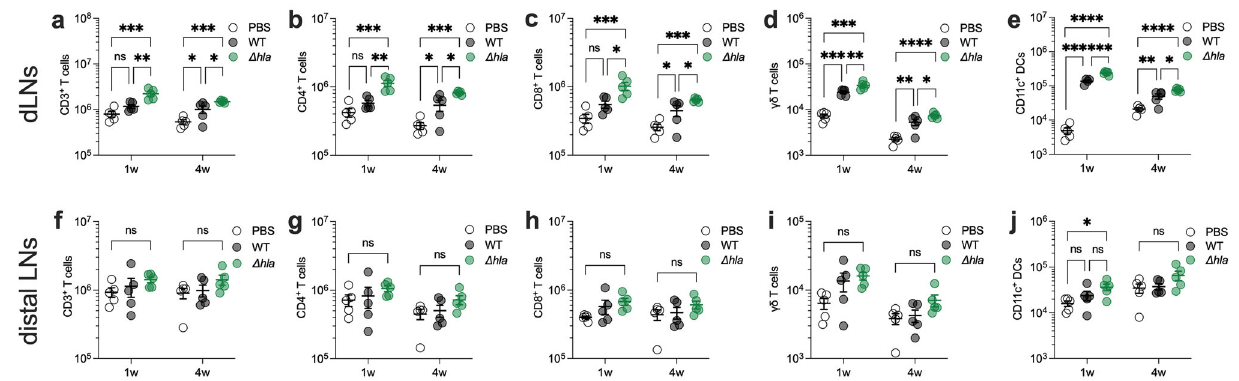
Fig. 5 Hla expression during SSTI durably impairs the expansion of T cells and dendritic cells in draining lymph nodes. Following SSTI with wild-type (WT) S. aureus or an isogenic hla deletion mutant ( Δ hla ), local draining lymph nodes (dLN) or distal LN were harvested 1 and 4 weeks after infection, and fl ow cytometry performed to quantify CD3 + , CD4 + , CD8 + , or γδ T cells and CD11c + dendritic cells (DC). a – e There were higher numbers of all cell populations tested in local dLNs following infection with Δ hla , compared with WT. These differences persisted for 4 weeks following the infection. f – j In contrast, there were no signi fi cant differences in the numbers of T cells and DCs in distal LNs 1 or 4 weeks following infection between mice infected with WT or Δ hla . N = 5 mice/group; one representative experiment of at least two repeats is presented. Data are presented as mean ± SEM and were analyzed using one-way ANOVA on log 10 -transformed values with Tukey ’ s post-test. * indicates p < 0.05; ** p < 0.01; *** p < 0.001; **** p < 0.0001; NS not signi fi